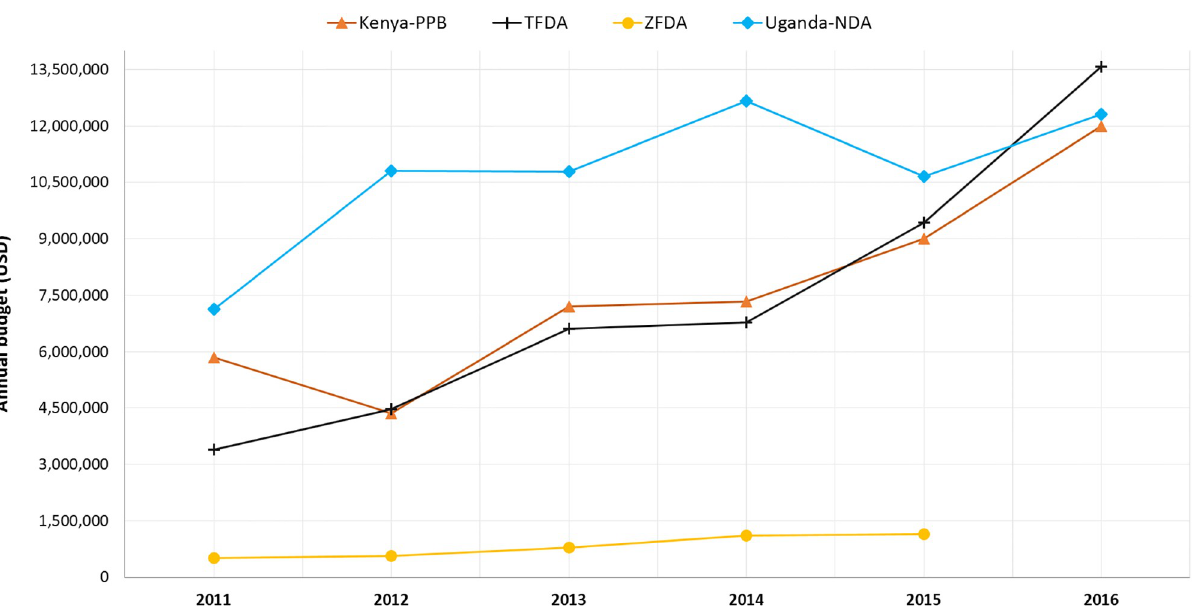
indicator was not available for Burundi’s and Rwanda’s NMRAs. When compared to their own baselines, the total annual budget of each NMRA approximately doubled over a duration of five years.